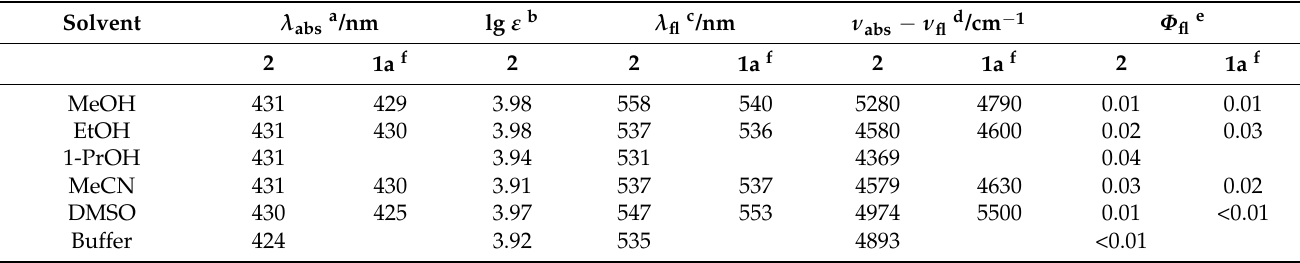
Table 1. Absorption and emission properties of derivatives 1a and 2 in different